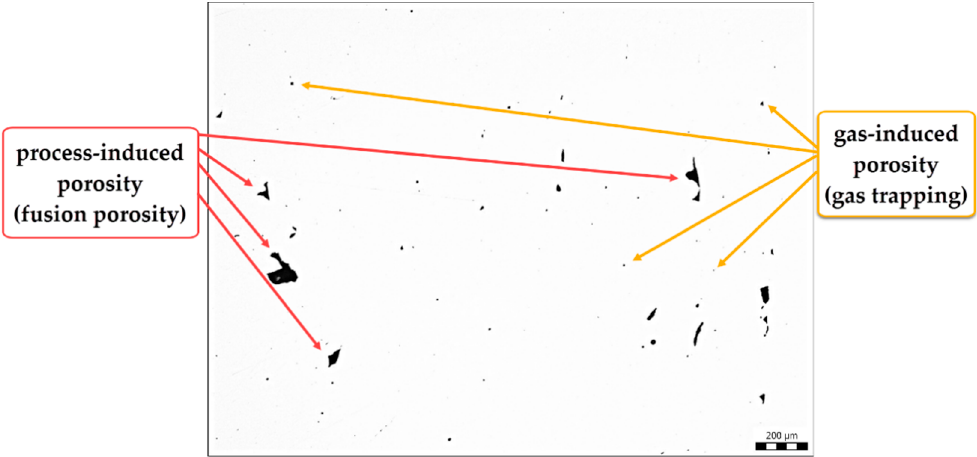
Figure 5. Porosity measurement with indication of the type of porosity.